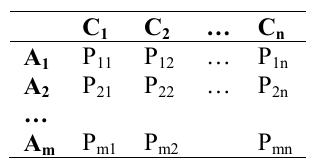
Table 2. Normalized alternatives' scores against